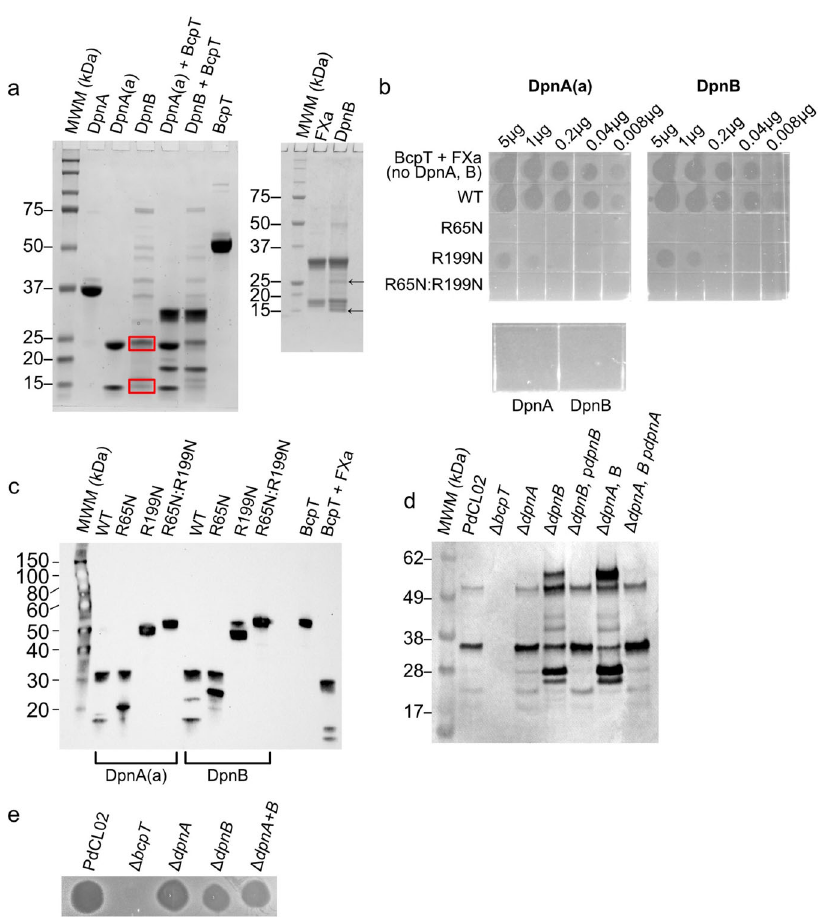
Fig. 4 C11 family proteases of P. dorei activate BcpT. a Left panel: Coomassie-stained gel of puri fi ed recombinant doripains (Dpns) and their ability to cleave BcpT. Puri fi ed recombinant doripain A (DpnA) incubated with trypsin at a 1:50 (w:w) trypsin to DpnA ratio for 15 mins at 37 °C was suf fi cient to cleave the activation loop without degradation of the protein. DpnA activated in this manner is referred to as DpnA(a). Red boxes indicate cleaved doripain B (DpnB) fragments that eluted with contaminating proteins from E. coli , possibly due to their association with DpnB. Right panel: FXa and DpnB cleaved BcpT showing the same sized fragments are generated. Arrows indicate the DpnB protease fragments that result from its activation b Agar overlay assays showing that the Dpns can activate BcpT like FXa and inhibit the growth of Pv8482. Dpns did not activate the R65N or the R199N-R65N double mutants, however, a weak activation of the R199N was observed. Although this assay is only semi-quantitiative, the spot of the undiluted R199N (5 μ g) most closely resembled that of the 0.04 μ g spot of the WT, which is <10% of WT activity. c Western immunoblot of puri fi ed BcpT and site mutants of BcpT cleaved by DpnA(a) and DpnB. The blot was probed with α -BcpT. Note that the smaller fragment in the R65N in the DpnA is smaller than that of the DpnB cleaved R65N mutant. We have found that DpnA cleaves the His-tag more ef fi ciently than DpnB which accounts for the difference in size of the small fragment of ~2.5 kDa. d Western immunoblot analysis of BcpT cleavage products in the supernatant of PdCL02 and dpn mutants and complemented mutants. e Agar overlay assay analyzing the ability of PdCL02 dpn mutants to inhibit the growth of PvCL10. Overlays and BcpT cleavage analyses were performed two to three times with consistent results. All gels and blots were perfomred a minimum of two times with consistent results. Source data are provided as a Source Data fi